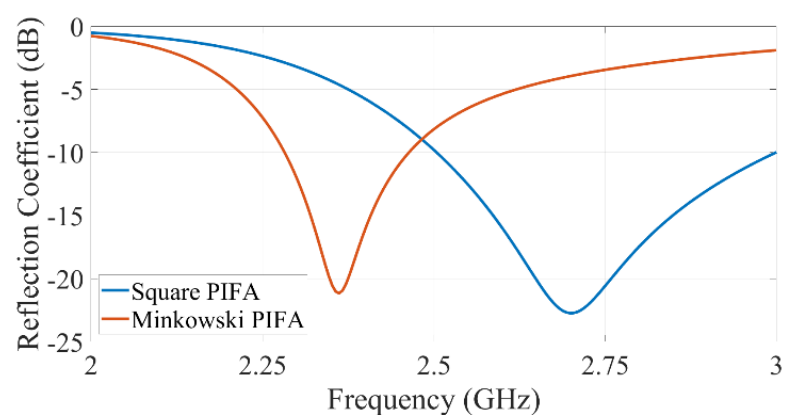
Figure 2. Simulated reflection coefficient: comparison between the Minkowski pre-fractal-shaped PIFA and the conventional square PIFA design.